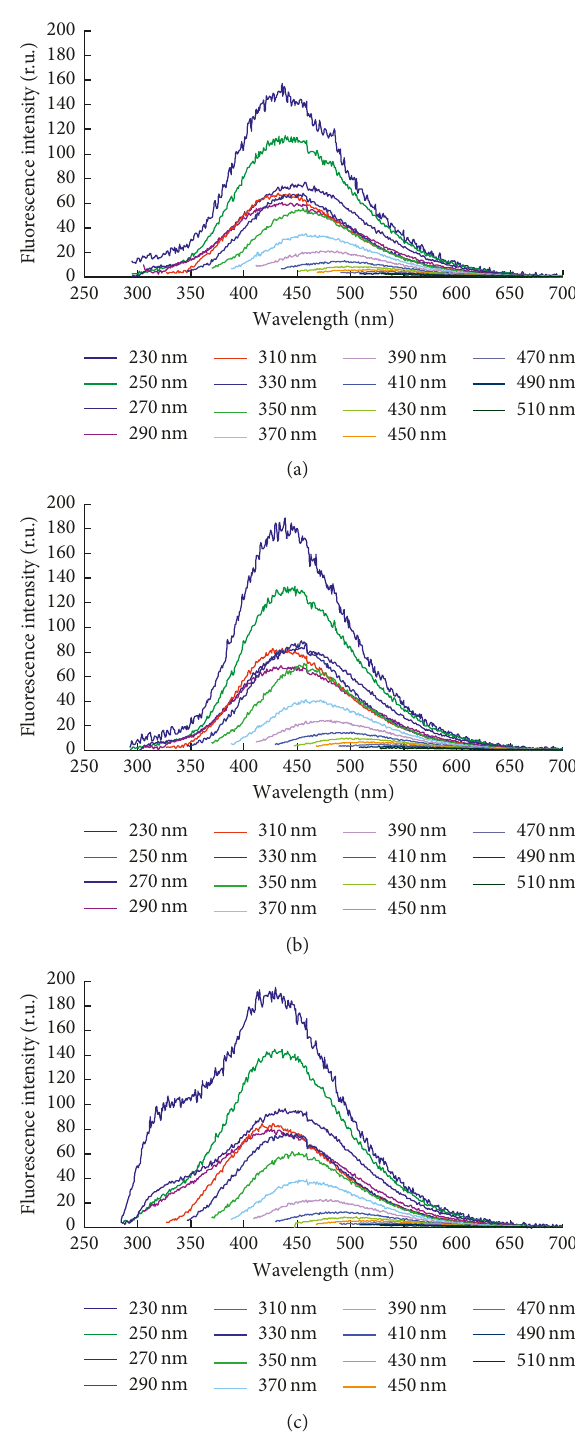
Figure 2: Fluorescence emission spectra of CDOM samples from three Karelian lakes at excitation wavelengths varying from 230 to 510 nm. (a) Verhnee lake. (b) Vodoprovodnoe lake. (c) Onego